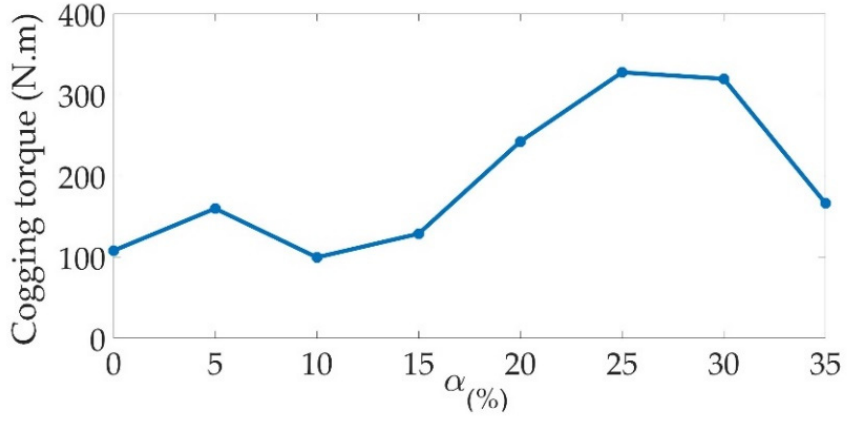
Figure 14. Cogging torque peak-to-peak magnitude for different ratios α ( β = 50%).